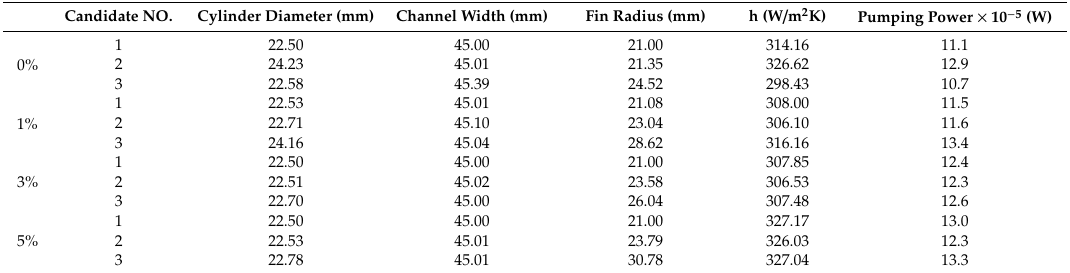
Table 10. Predicted candidate points provided by the response surface optimization.